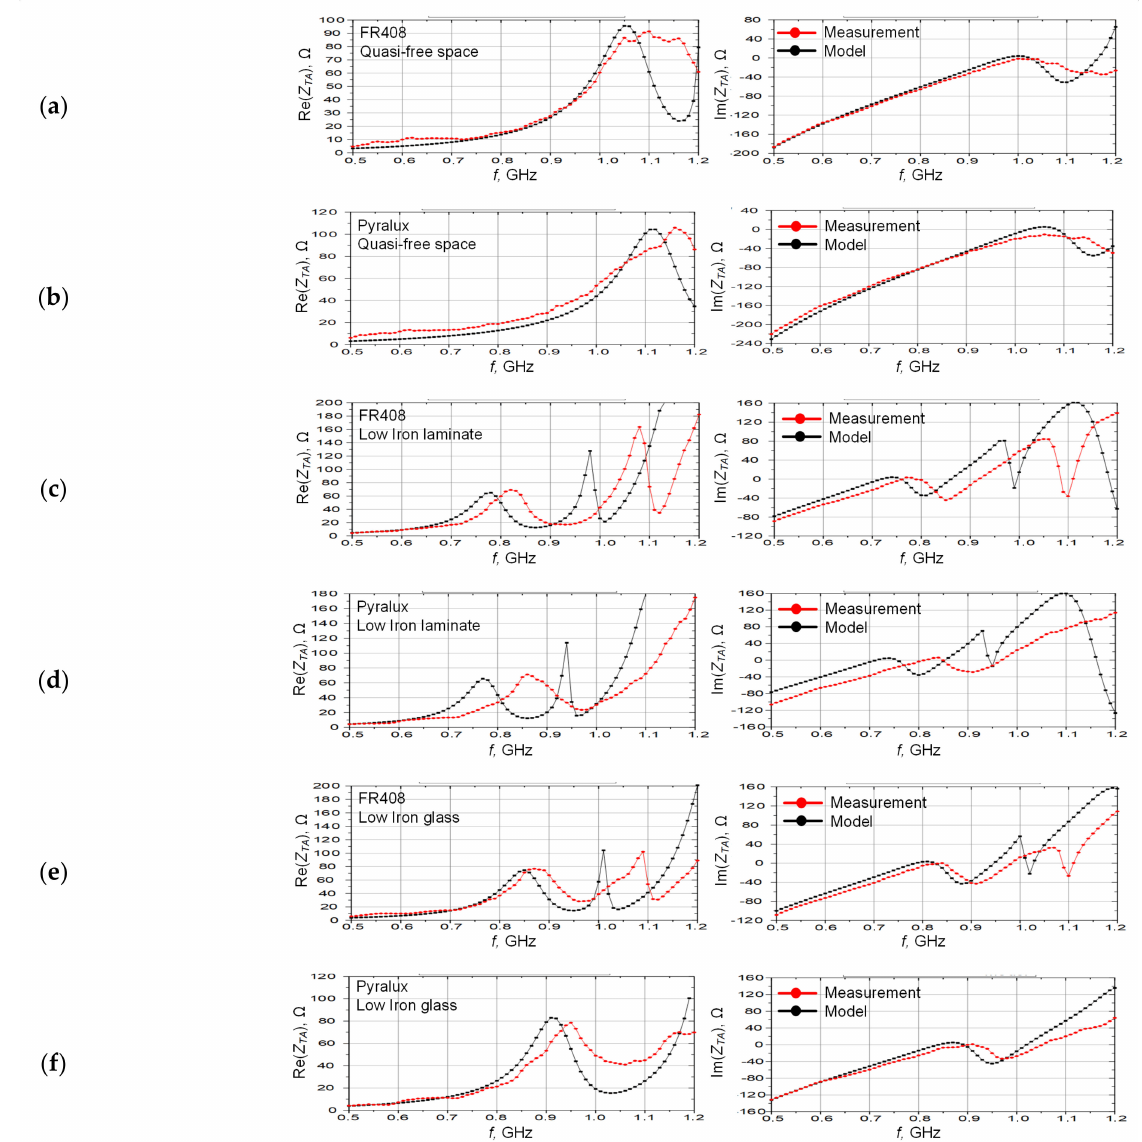
Figure 4. Impedance (Re—realism, Im—imaginalism) of RFID antenna on substrate: ( a , c , e ) ISOLA FR408; ( b , d , f ) DuPont Pyralux, obtained for: ( a , b ) quasi-free space conditions; ( c , d ) stack with low-iron laminate sample; ( e , f ) stack with low-iron glass